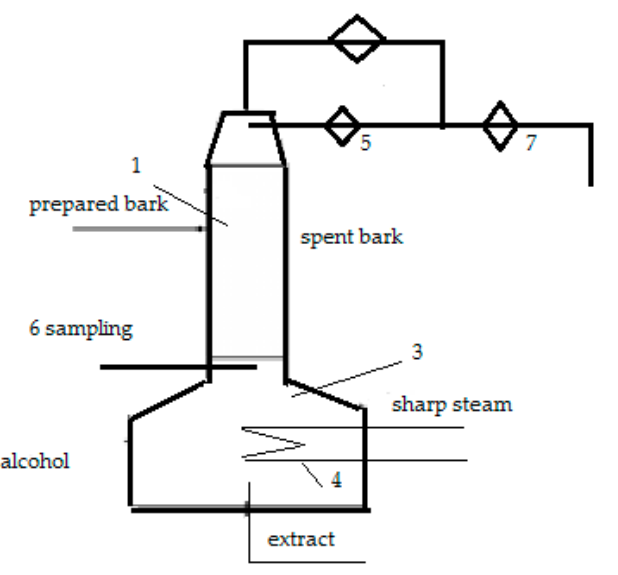
Figure 6. Extractor design.